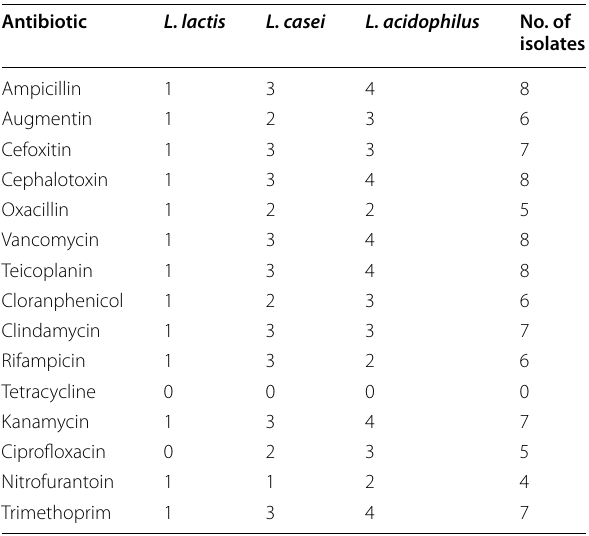
Table 2 No. of isolate resistance to antibiotics of the representative strains of lactic acid bacteria isolated from dairy products Antibiotic